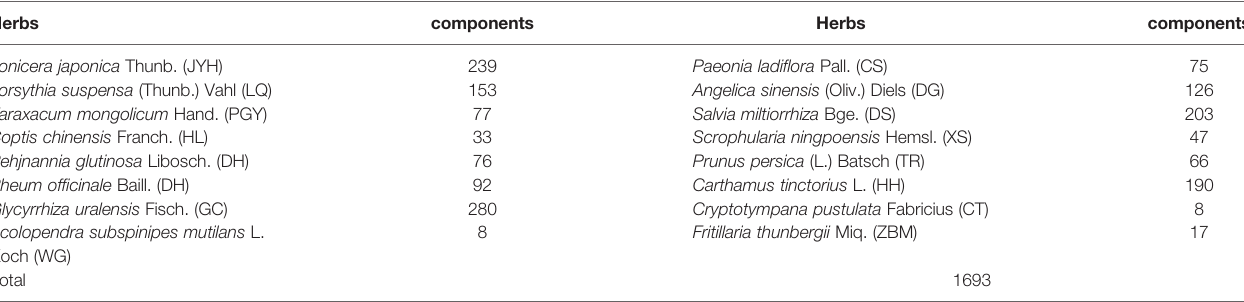
TABLE 2 | The number of LCW components collected in the published databases. Herbs components Herbs components